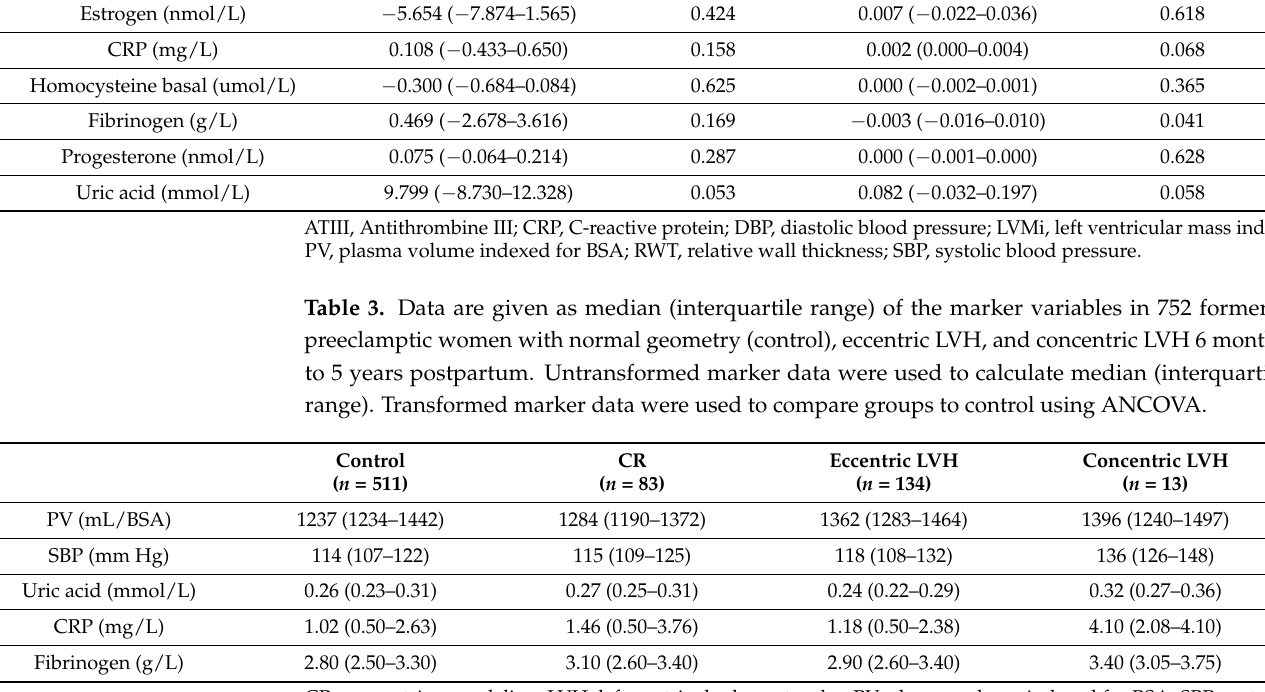
Table 4. Univariable and multivariable linear regression model with RWT as outcome using trans- formed data set. The regression coefficients were used to formulate a formula: RWT = 0.248 +